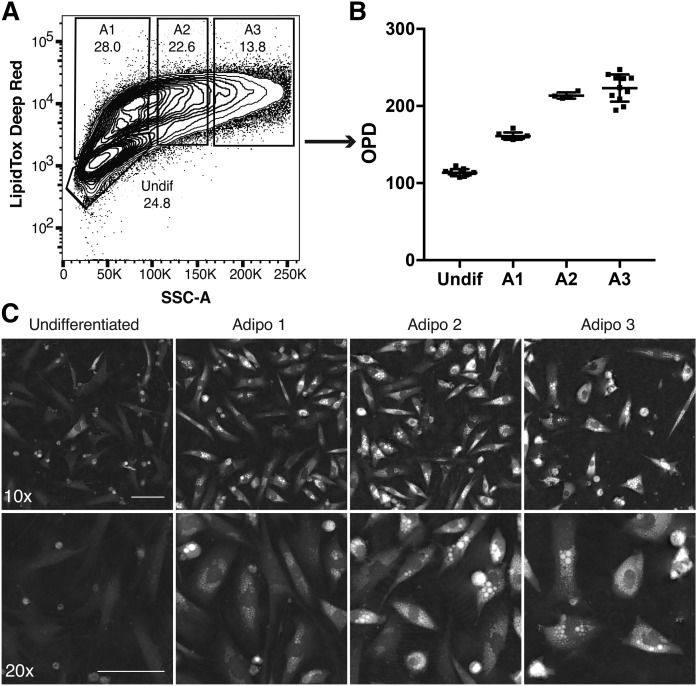
OPD signal of FACS-sorted OP9 cells induced to differentiate toward adipocytes during a time period of 6 days. A: Flow cytometric gates were chosen along the SSC signal (representing different stages of lipid accumulation), sorted separately, and subsequently plated into a 384-well plate. B: Average OPD signal of sorted OP9 cells 24 h after plating. Images without cells were removed from analysis. C: Representative DHM images of sorted OP9 cells. Top, 10× bottom, 20×. Error bars are SD. Scale bars = 100 μm.